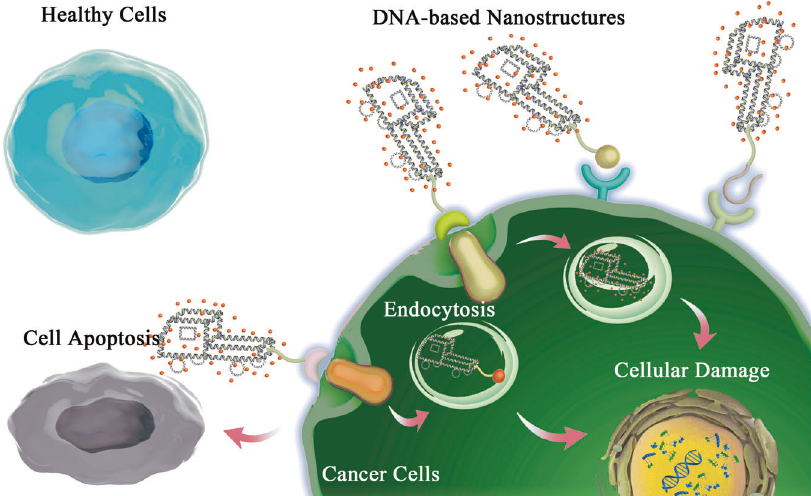
Fig. 3 DNA-based nanostructures on tumor therapy by modi fi cation with drug, aptamer, or other functional ligands act various biological functions, which can bind to the target protein of cells. DNA-based nanostructures could distinguish cancer cells via ligand-receptor binding and permeate the membranes through endocytosis. The corresponding release of therapeutical agents would cause cellular damage and lead to apoptosis of cancer